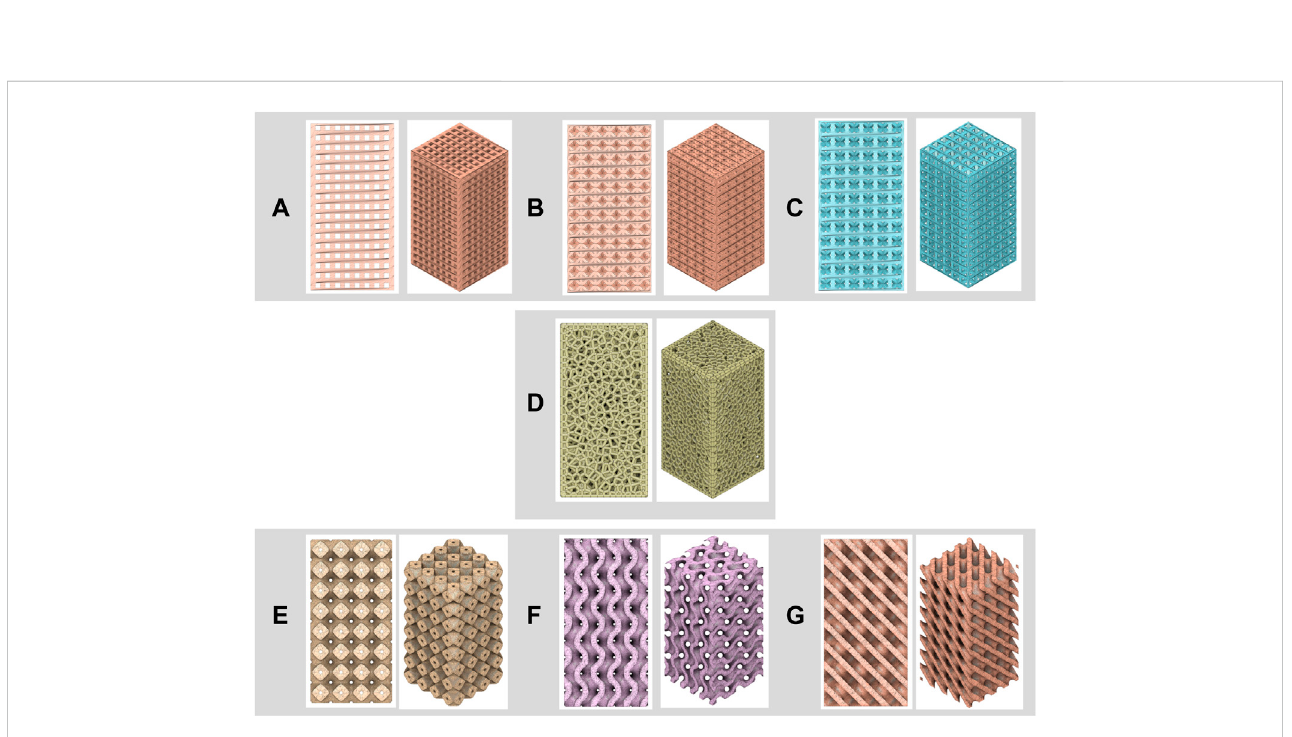
FIGURE 5 The microarchitecture of the bone scaffold